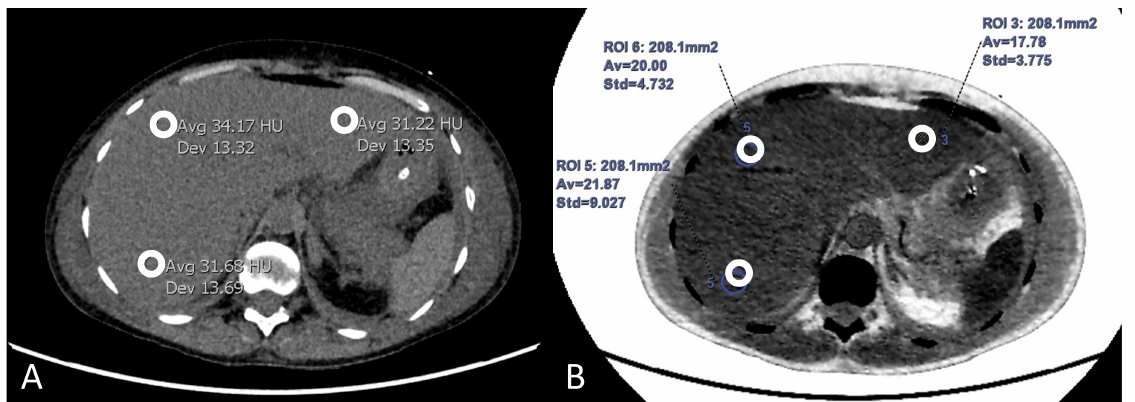
Figure 1. An example of measurements from ROIs placed at three designated liver positions in the left and right liver lobe within the same patient. ( A ) The HU measurements for a conventional non-contrast CT scan. ( B ) The corresponding fat percentage measurements made within the AW software on an arterial phase reconstruction. The ROIs in ( A , B ) are marked with white